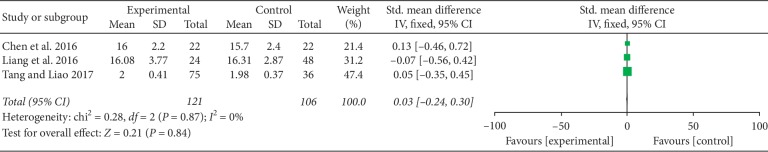
IOP forest map after follow-up.